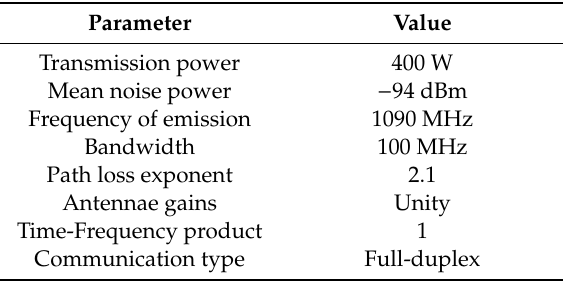
Table 4. A-TDOA system communication parameters for optimization. Their election has been made based on aeronautical tracking applications [38], with the objective of representing the use of generic technology in the CRLB